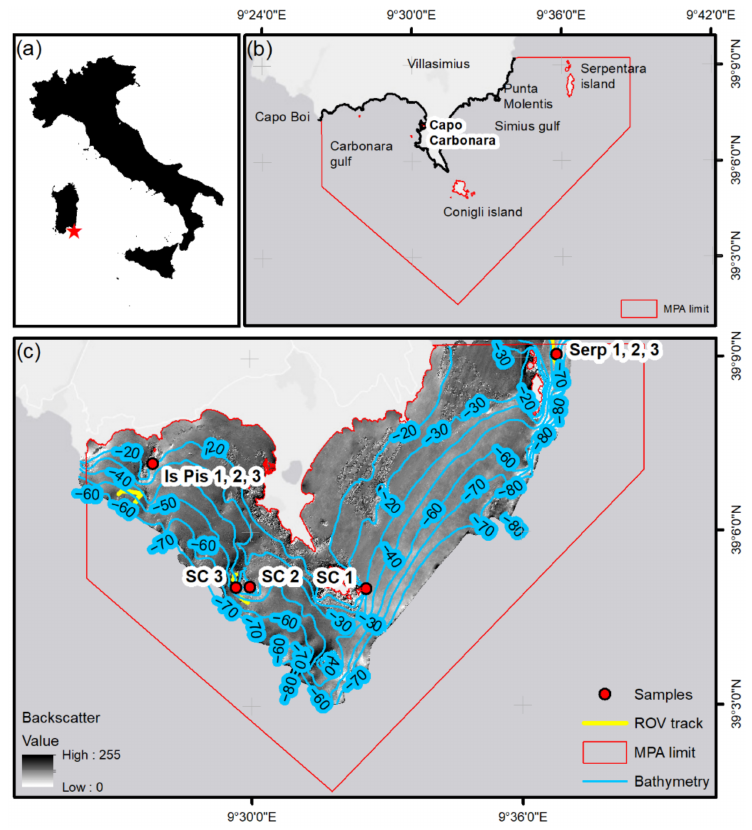
Figure 1. ( a , b ) geographical location of the studied area, with the indication of the MPA limit; ( c ) backscatter photomosaic of the area (property of the MPA) with the indication of the ROV tracks and sampling location. Is Pis is for Is Piscadeddus, SC is for Santa Caterina, and Serp is for Serpentara. Service layer credit in ( b , c ): Esri, HERE, Garmin, (C) OpenStreetMap